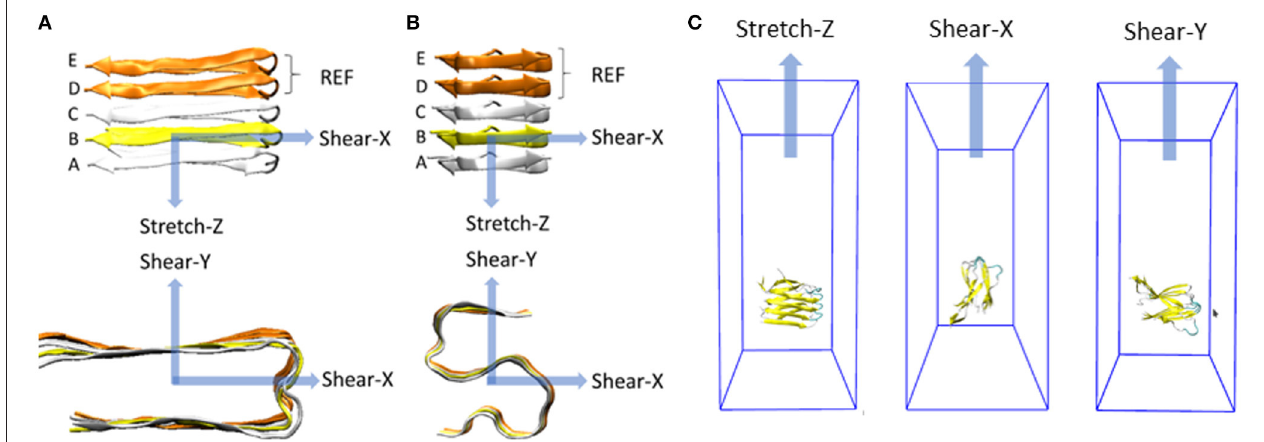
FIGURE 1 | Representation of the deformation protocols applied to the fibril model in case of (A) U-shaped and (B) S-shaped. Each deformation is defined by a pulling direction, highlighted by the blue arrow. For each deformation, the constrained pulled group and the restrained reference group (both composed only by C-alpha atoms) are evidenced in yellow and orange, respectively. All the other atoms of the peptides are free to move. Molecular systems inside their simulation box throughout stretch and shear SMD simulations are shown in (C)